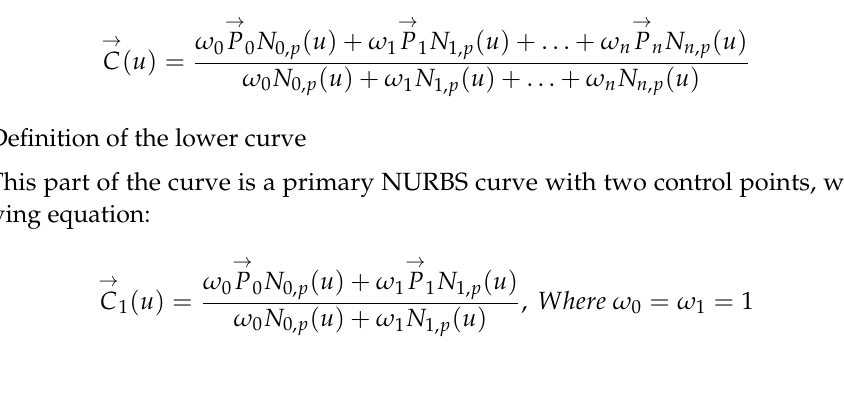
divided into three parts: between the deck line and the waterline (upper curve), between the waterline and the flat-bottomed line (middle curve), and from the flat-bottomed line to the keel line (lower curve). At different x -positions, although its shape varies, the cross-section curve at each stop intersects the boundary curves (deck line, water line, flat-bottomed line, keel line), i.e., the starting and ending positions of the three parts of the curve are uniquely step is to determine the intersection points of the corresponding cross-section curves